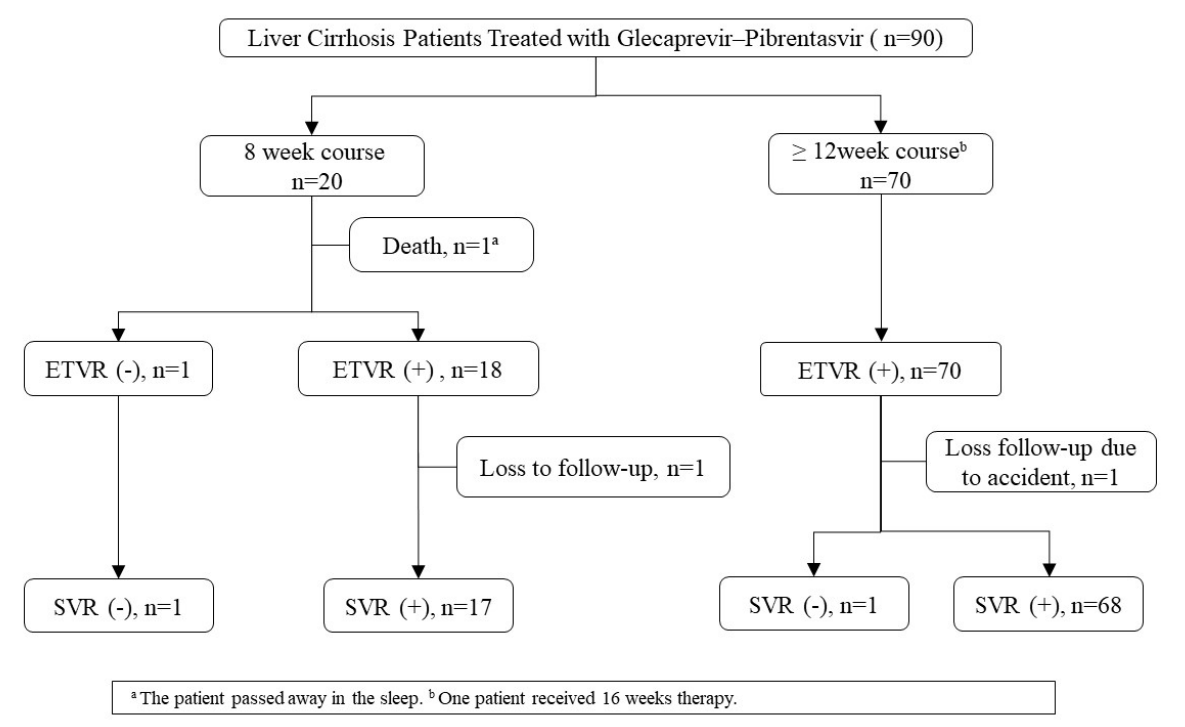
Figure 1. Flowchart showing baseline data of hepatitis C virus compensated cirrhotic patients with glecaprevir/pibren- tasvir. Table 1. Baseline characteristics of the study population.